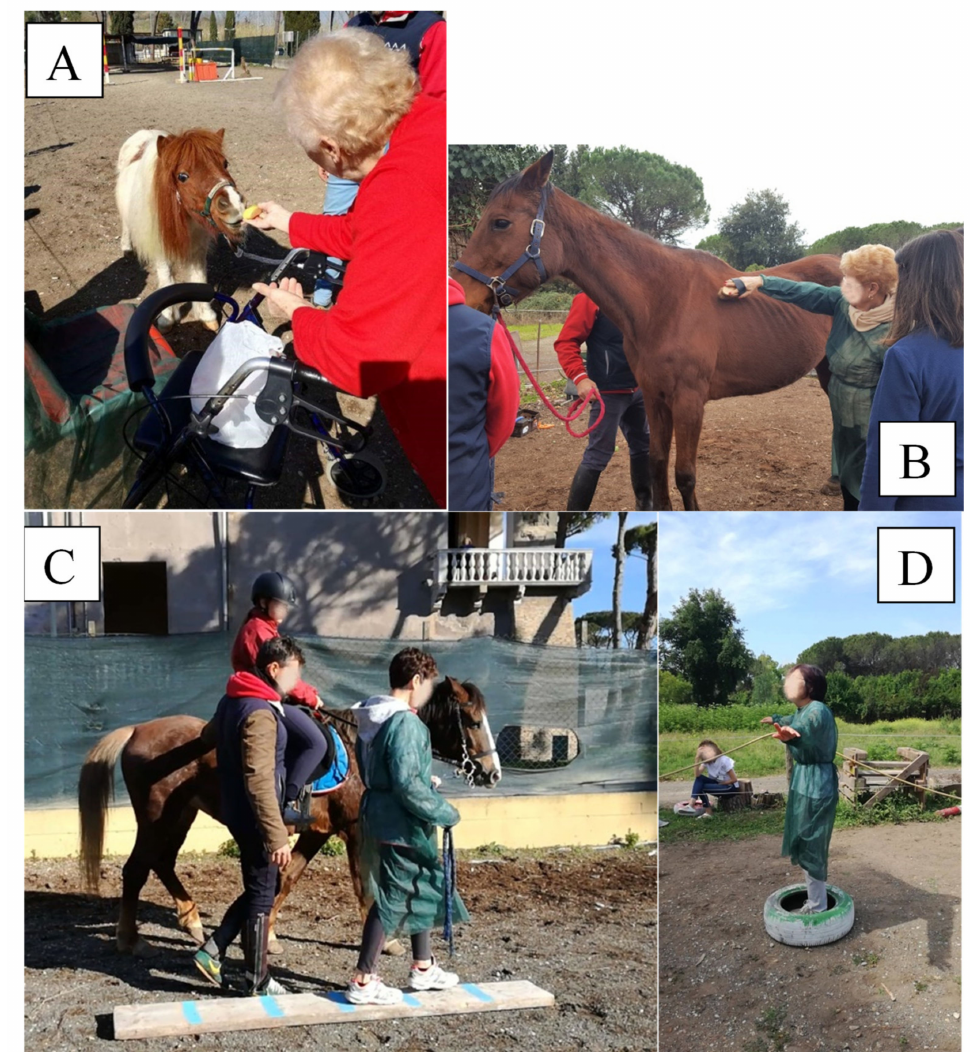
Figure 1. Vocalization exercises ( A ), care and cleaning activity ( B ), horse-assisted walking activity ( C ), and exercises of breathing ( D ) performed by individuals with Parkinson’s disease on the equine therapy